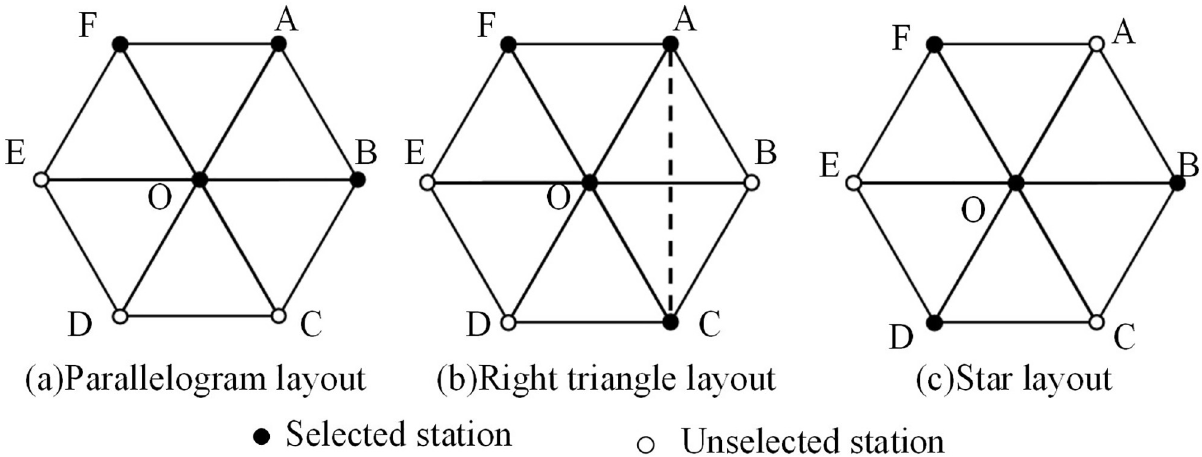
Fig 5. Three kinds of layout in cellular networks. (a) Parallelogram layout, (b) Right triangle layout, (c) Star layout. • Selected station, � Unselected station.